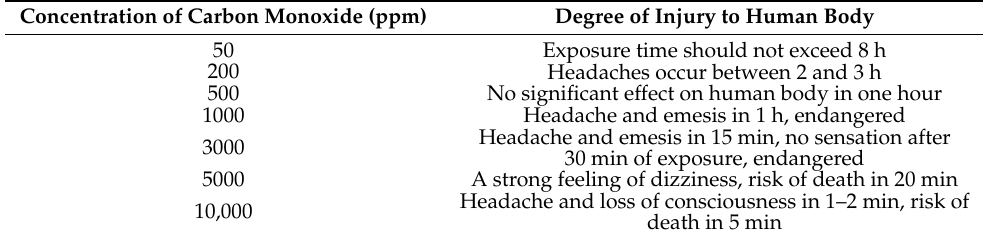
Table 2. Effects on the human body under different CO concentrations.